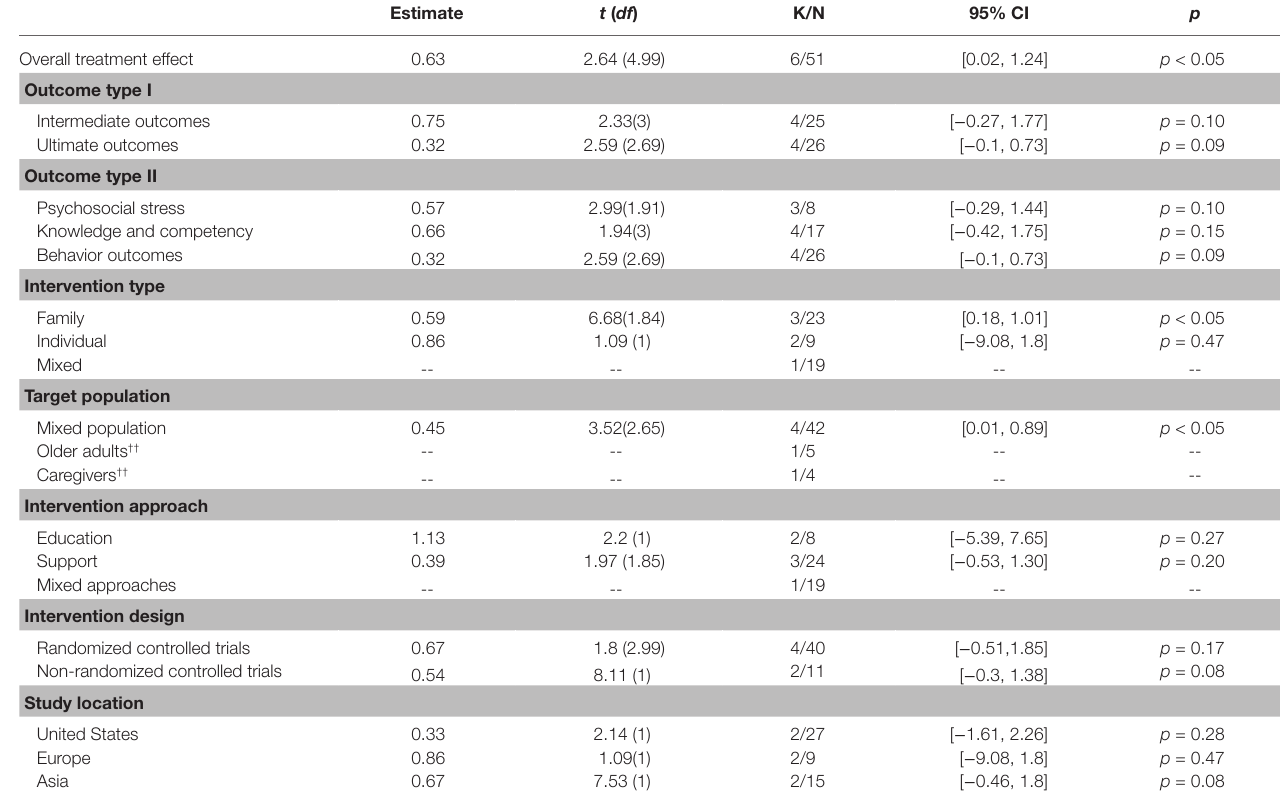
TABLE 2 | Overall and sub-group meta-analysis.